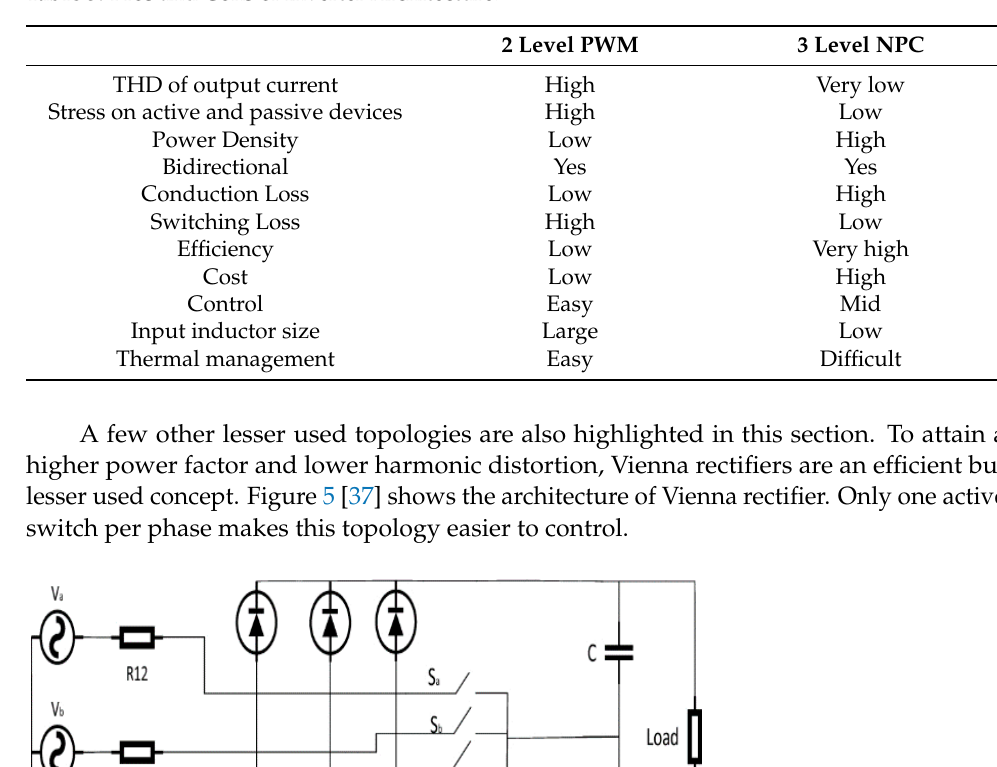
Table 3. Pros and Cons of Inverter Architecture.